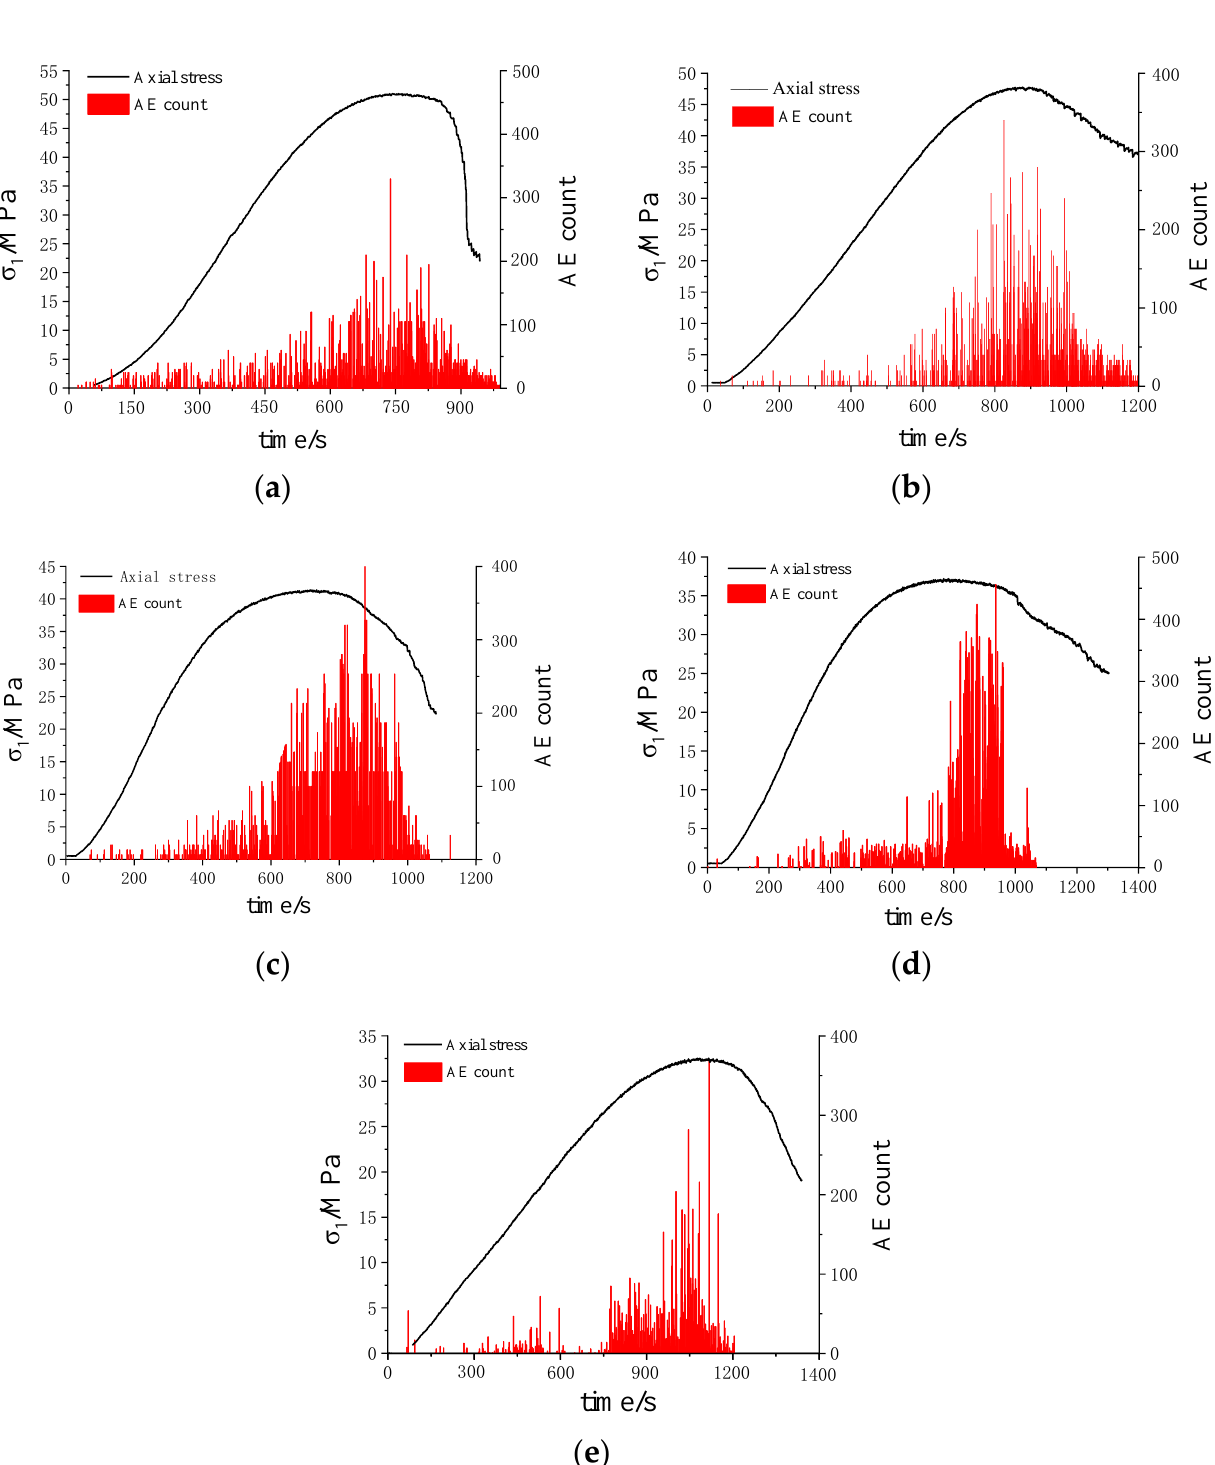
Figure 12. The stress-time-AE count curves of the gypsum rocks with the different immersion times: ( a ) Natural, ( b ) 1 day, ( c ) 7 days, ( d ) 15 days, and ( e ) 30 days.